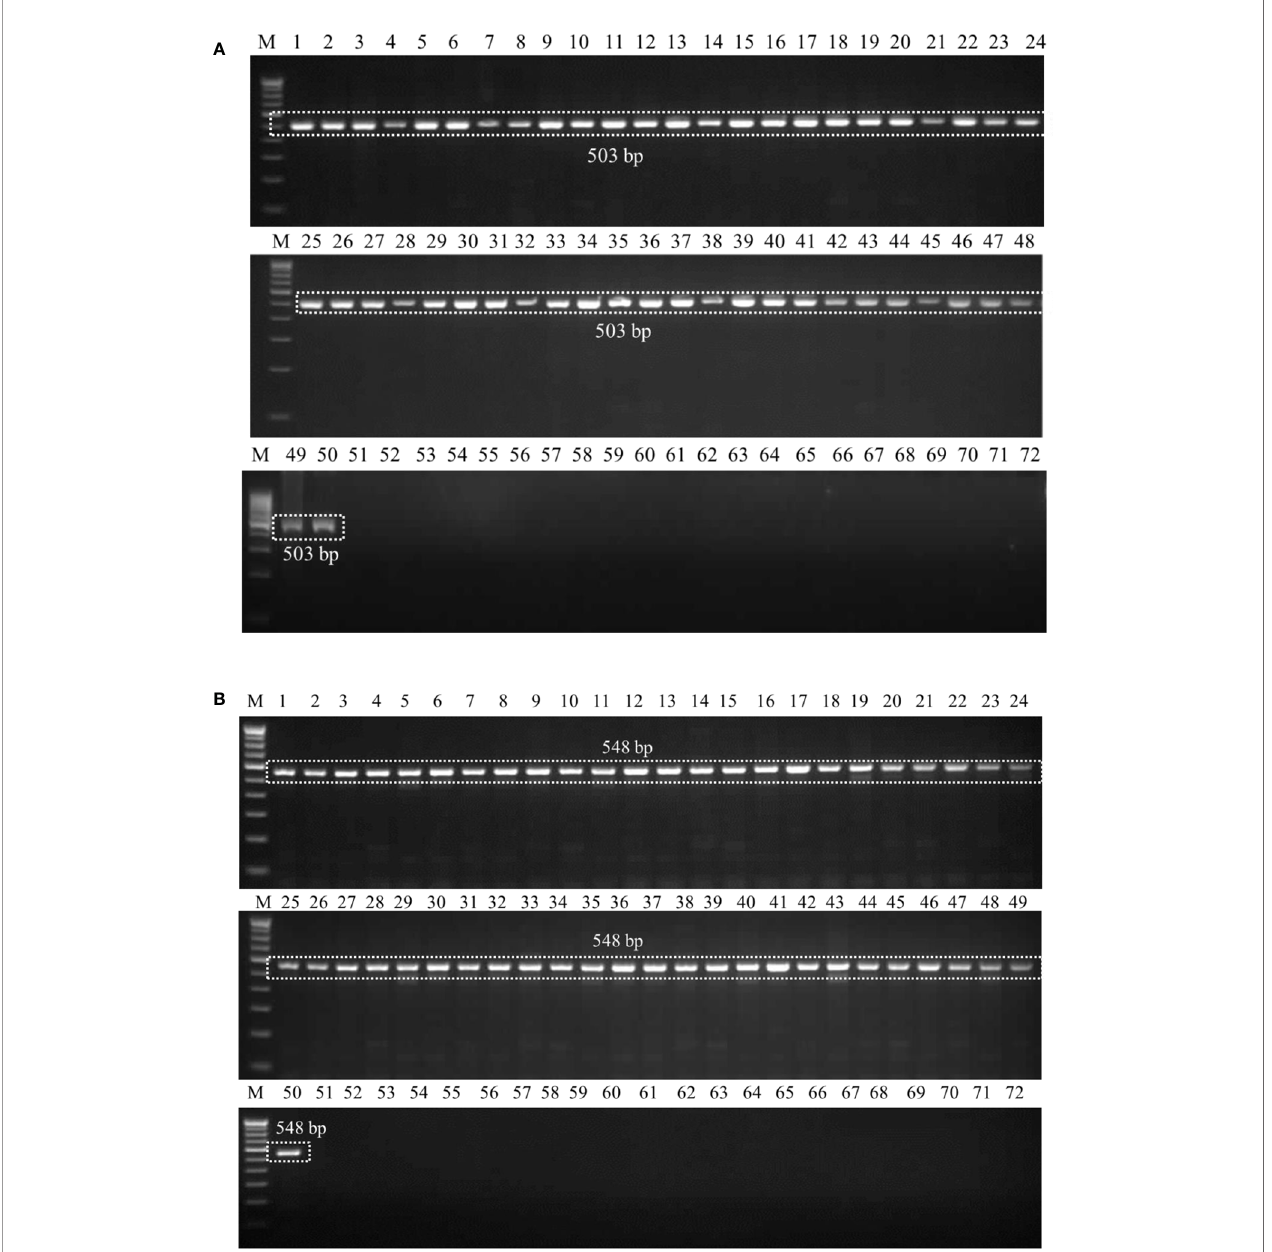
FIGURE 2 | (A) Agarose gel electrophoresis showing the PCR product (503 bp) ampli fi ed using the UA-17F/UA-519R primer sets from the fungal isolates listed in Table 1 . M: 100 bp DNA ladder; Lane 72 indicates negative control (NC) without DNA template. (B) Agarose gel electrophoresis showing the PCR product (548 bp) ampli fi ed using the UA-15F/UA-562R primer sets from the fungal isolates listed according to Table 1 . M: 100 bp DNA ladder; Lane 72: Negative control (NC) without DNA